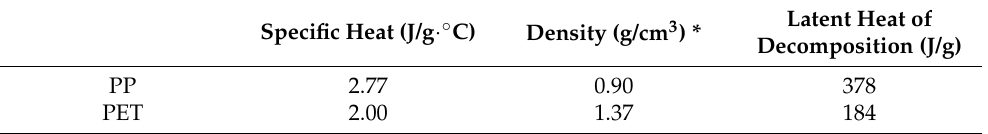
Latent Heat of Decomposi ‐ Latent Heat of tion (J/g) Decomposition (J/g)